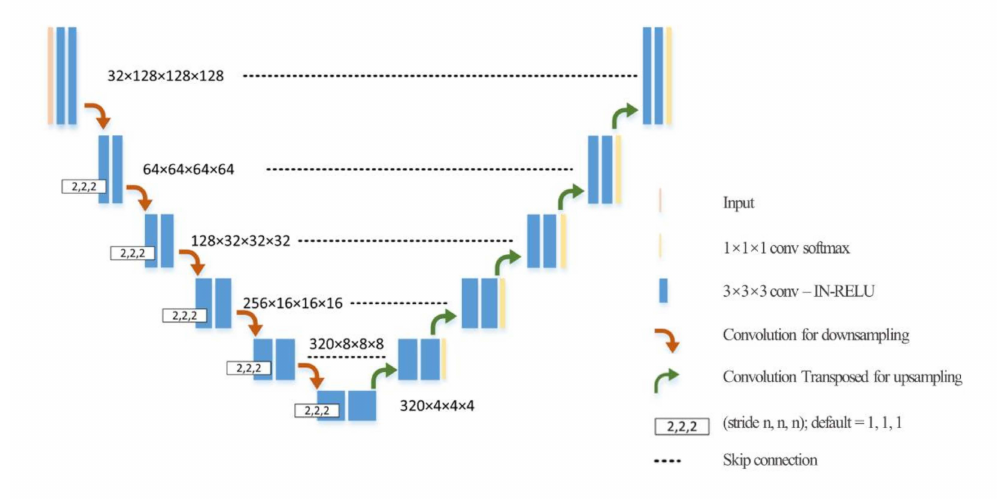
Figure 3. U-Net architecture for